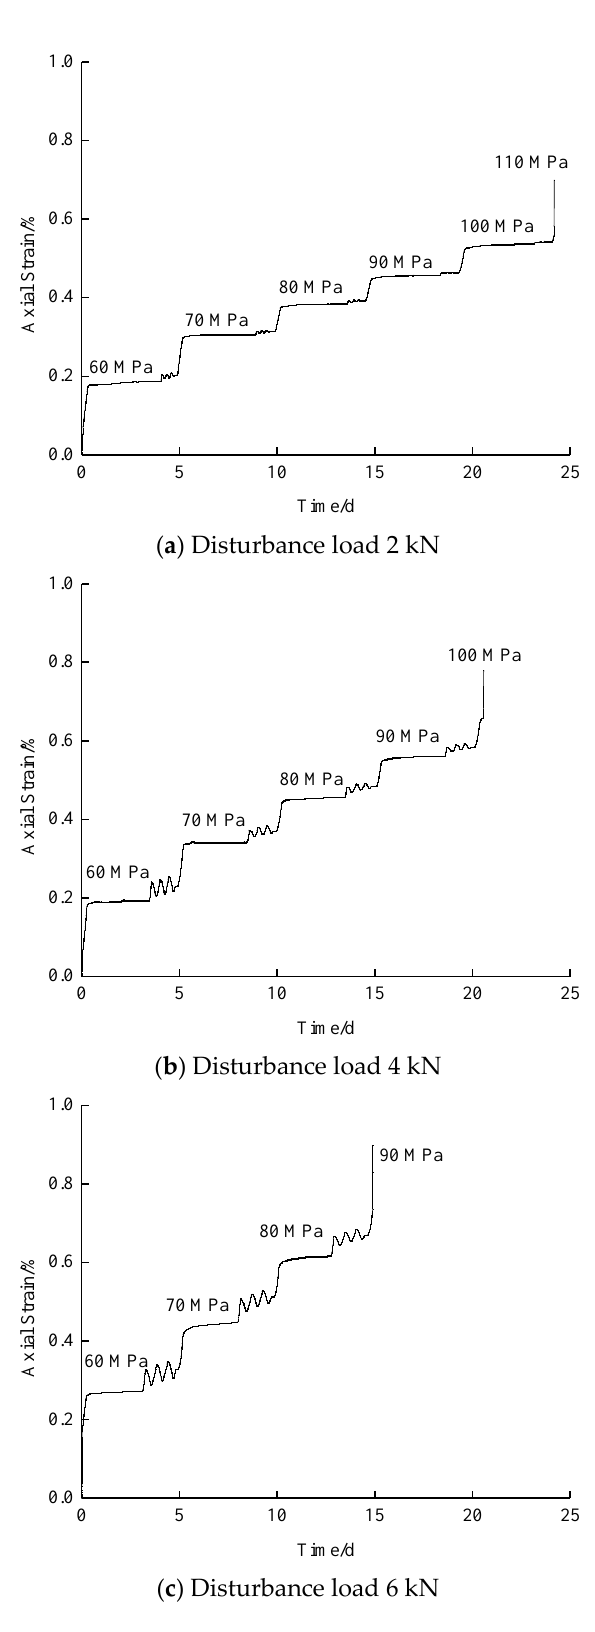
Figure 4. Axial creep curves of rock under different disturbance loads.